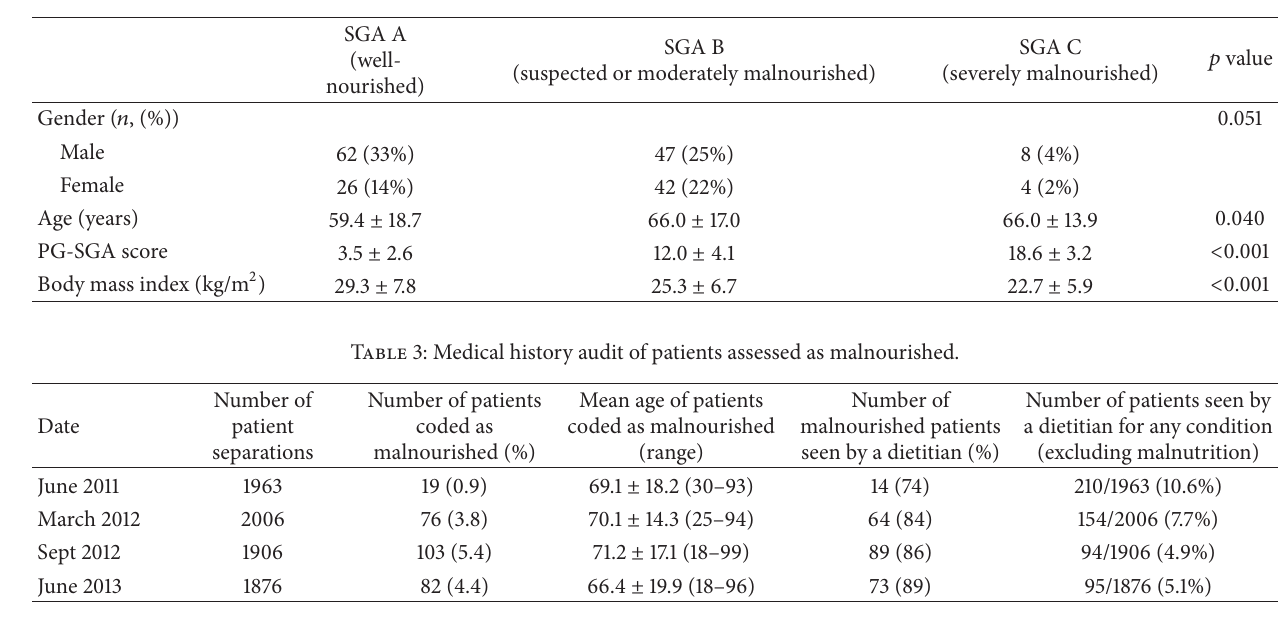
Table 2: Characteristics of patients according to malnutrition status as assessed by the Patient Generated Subjective Global Assessment (PG-SGA) tool (2012 study data, 𝑛 = 189 ).